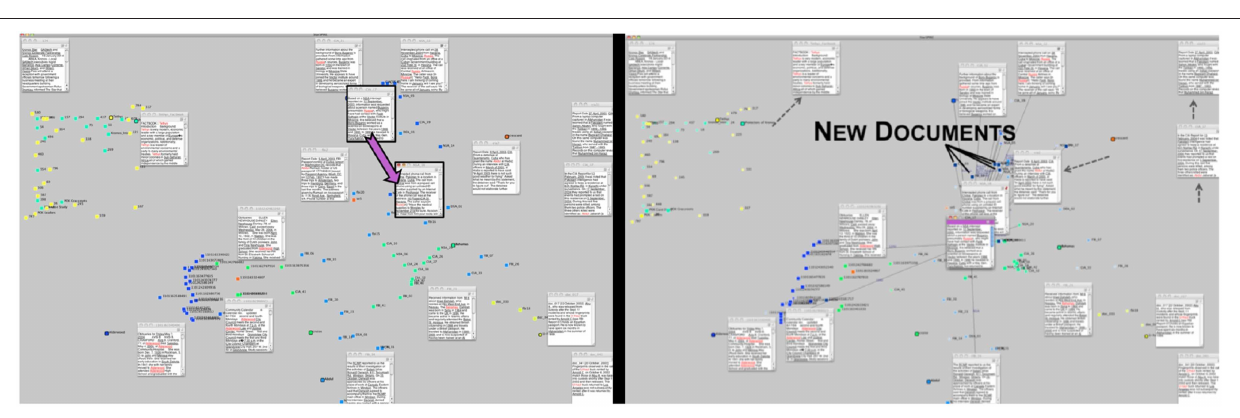
virtual navigation in a small display space (i.e., zoom and